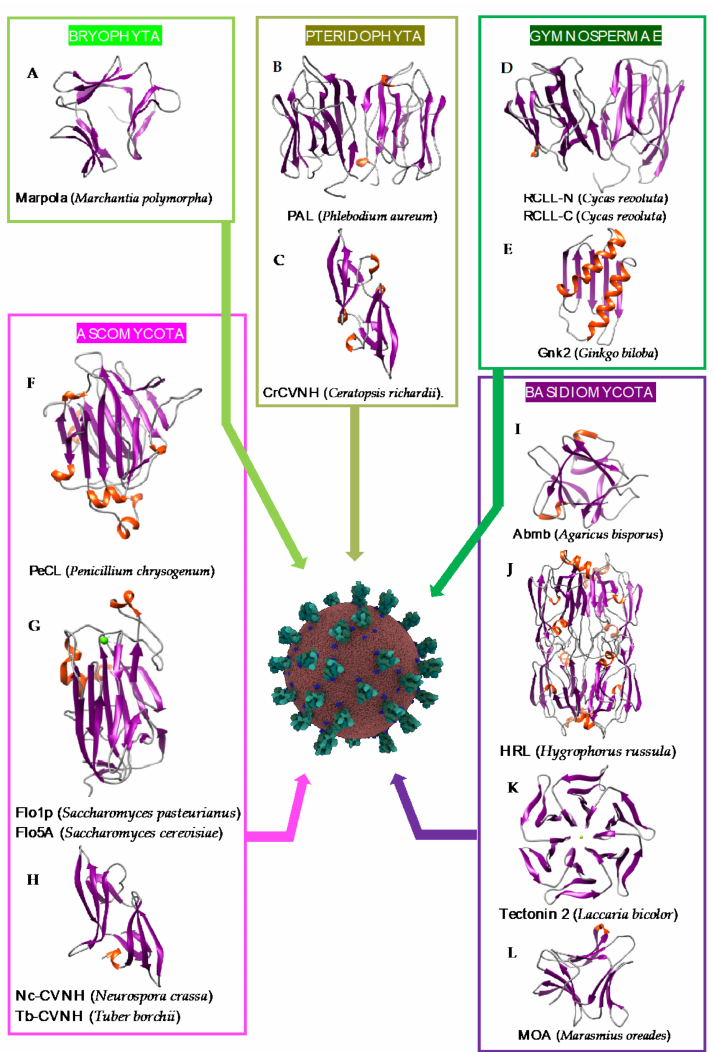
Figure 11. Overview of lectins from the major representative genera/species of lower plants and fungi, with their associated structural scaffolds, able to recognize the spike proteins from coronaviruses ( Coron- avirus Credit: Maria Voigt/RCSB PDB). A-L correspond to lectins used as structural scaffolds ( A ): Marpola, ( B ): PAL, ( C ): CrCVNH, ( D ): RCLL-N, ( E ): Gnk2, ( F ): PeCL, ( G ): Flo1p, ( H ): TbCVNH, ( I ): Abmb, ( J ): HRL, ( K ): Tectonin 2, ( L ): MOA. References [99–111] correspond to the lectins presented in the